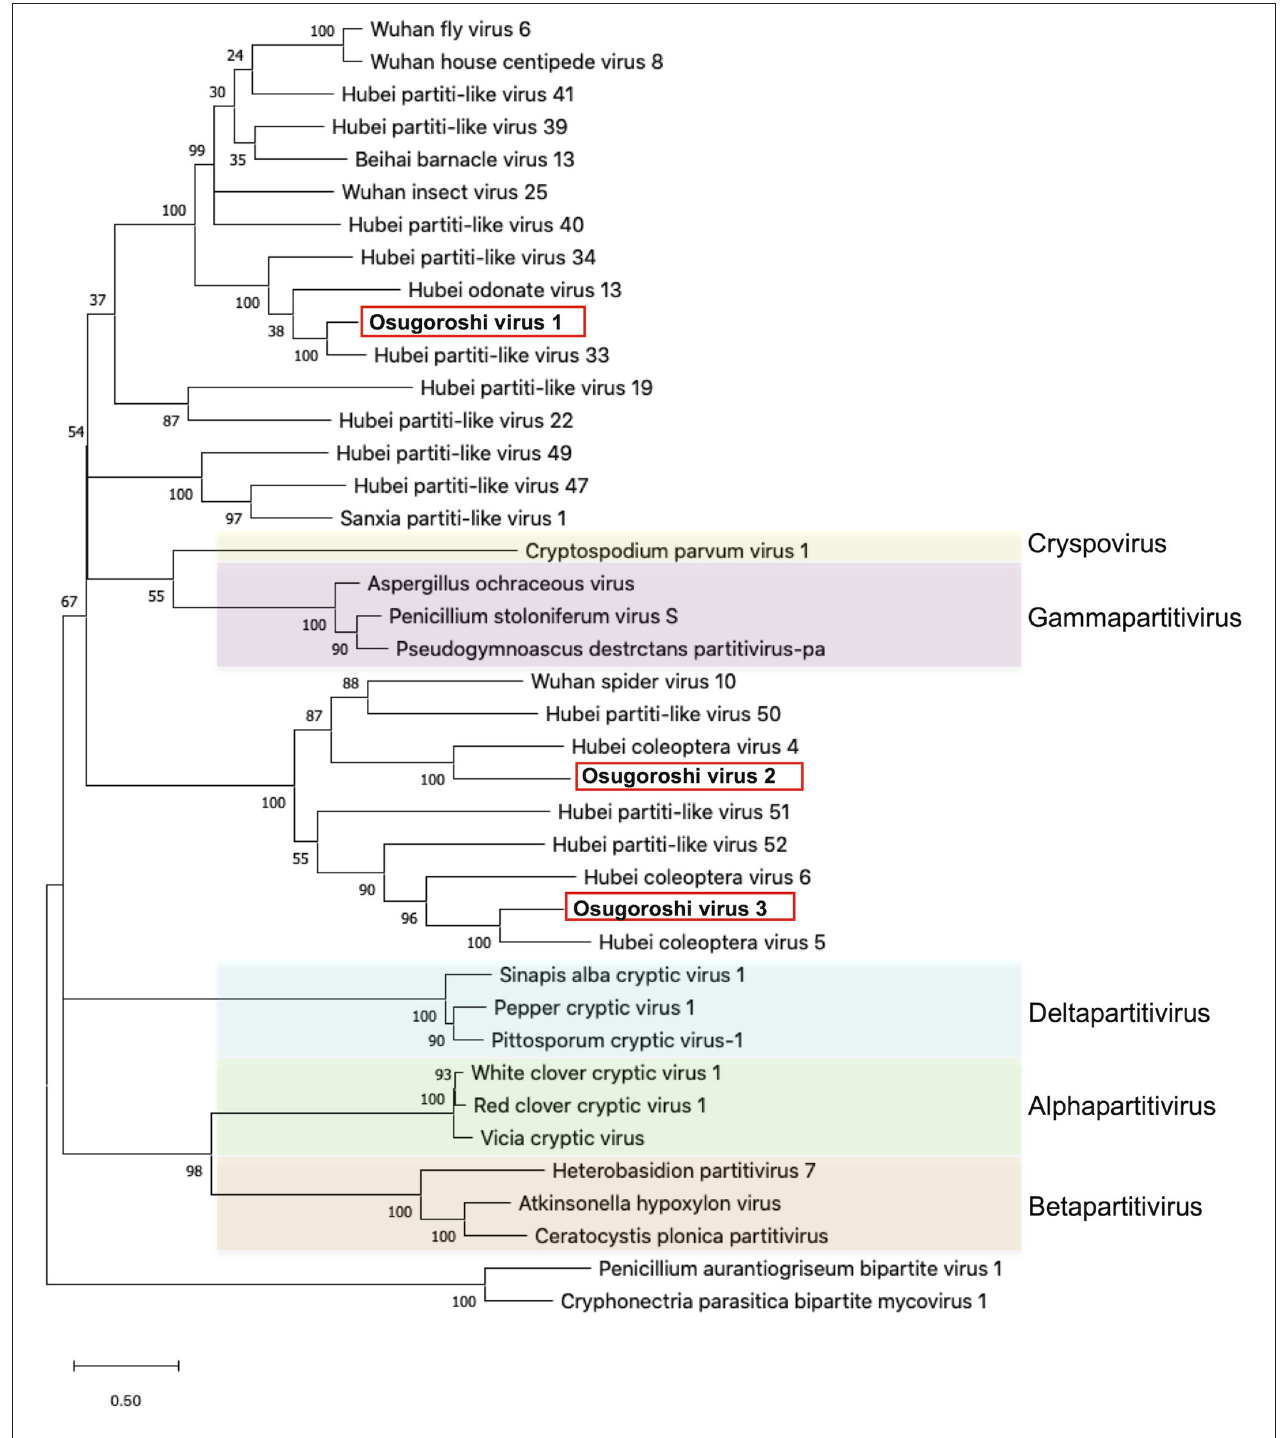
FIGURE 1 | Identification of partitiviruses in the Homona magnanima late strain. Phylogenetic analysis of the amino acid sequences of partitivirus RdRp was represented. The top 10 hits from BLAST analysis of Osugoroshi virus (OGV) 1, OGV2 (MK-25), and OGV3-encoded RdRp and 13 viruses categorized in previously defined genera (colored) were used in the alignment of two outgroup viruses (see also Supplementary Table 4 ).